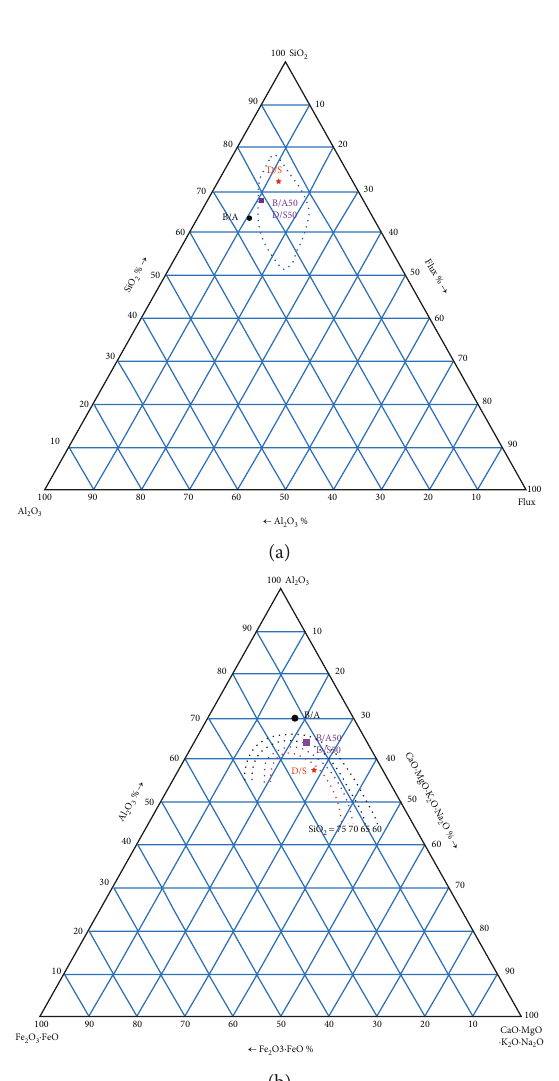
Figure 4: The raw material and the mixture are plotted in a triplet- state diagram. (a) Riley diagram [14]. (b) Cougny diagram [22].